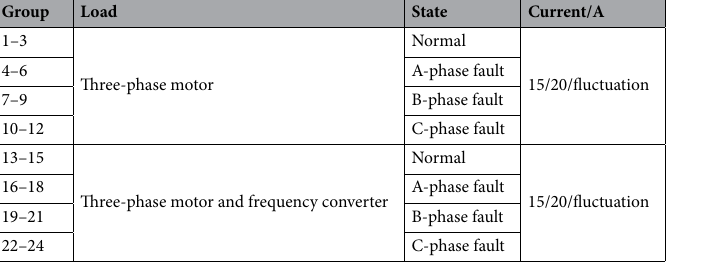
Table 1. Experimental